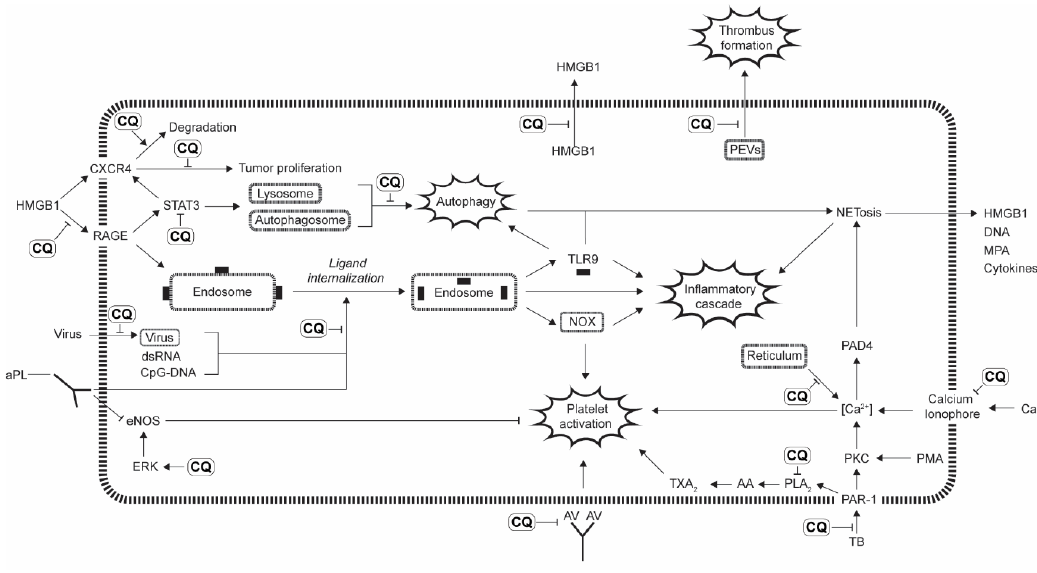
Figure 2. Summary of proposed mechanisms of actions of CQ.